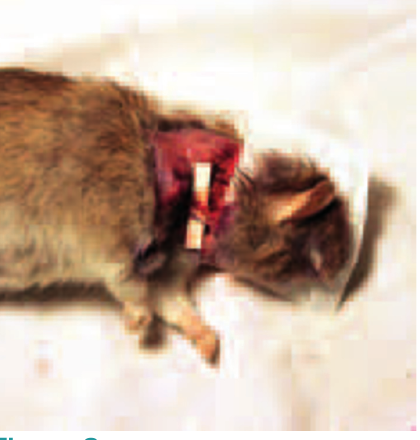
Figure 3. The vascular bundle (common carotid artery and exter- nal jugular vein)